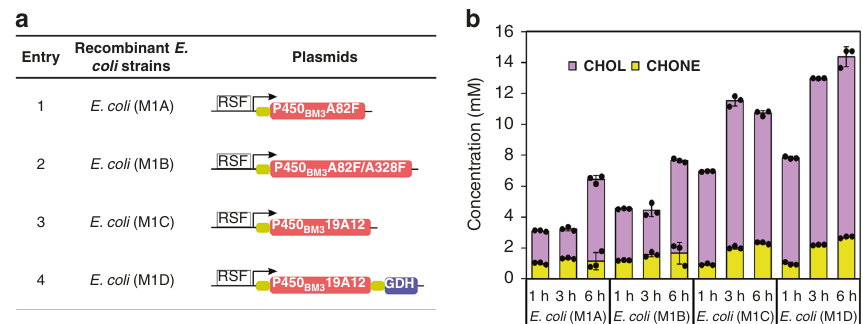
Fig. 5 Engineering of cell module 1 for converting CH 1b to CHOL 2b. a Construction of E. coli cells expressing P450 BM3 variants (A82F, A82F/A328F and 19A12) and glucose dehydrogenase (GDH). See Supplementary Fig. 6 for SDS-PAGE of whole-cell proteins of module 1 expressed in E. coli . RSF: pRSFDuet- 1; arrow: T7 promoter. Red fi lled rectangle: P450 BM3 variants genes; blue fi lled rectangle: GDH gene. b Engineered E. coli cells containing enzyme module 1 (P450 BM3 variants) for the biotransformation of CH 1b to CHOL 2b . Purple column: CHOL; yellow column: CHONE. The data shown in b are presented